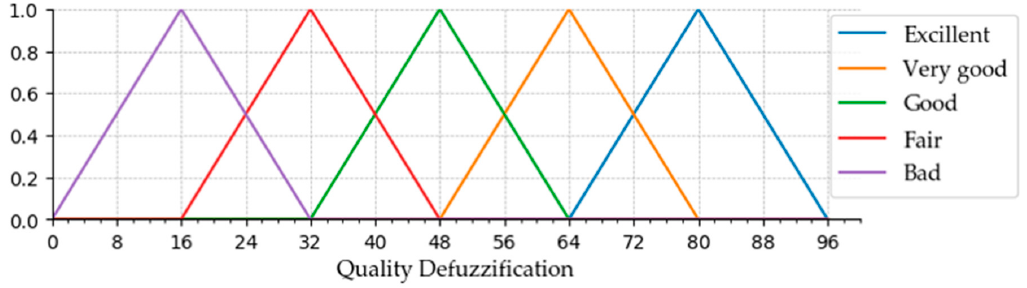
Figure 7. Output variable of quality of path.